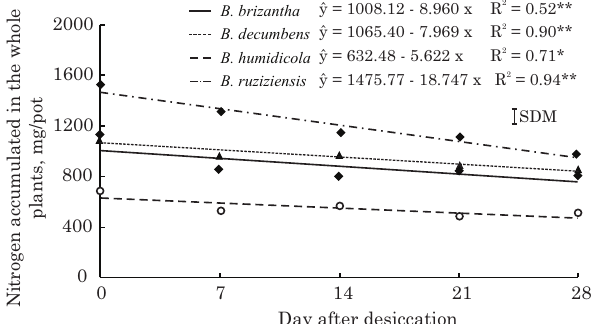
Figure 1. Nitrogen accumulated in the whole plants (shoots + roots) of B. brizantha , B. decumbens , B. humidicola and B. ruziziensis as a function of time after glyphosate desiccation. * and ** significant by the F test at 5 and 1 %, respectively. The vertical bar represents the standard deviation of the mean (SDM) obtained from the t test (LSD) at 5